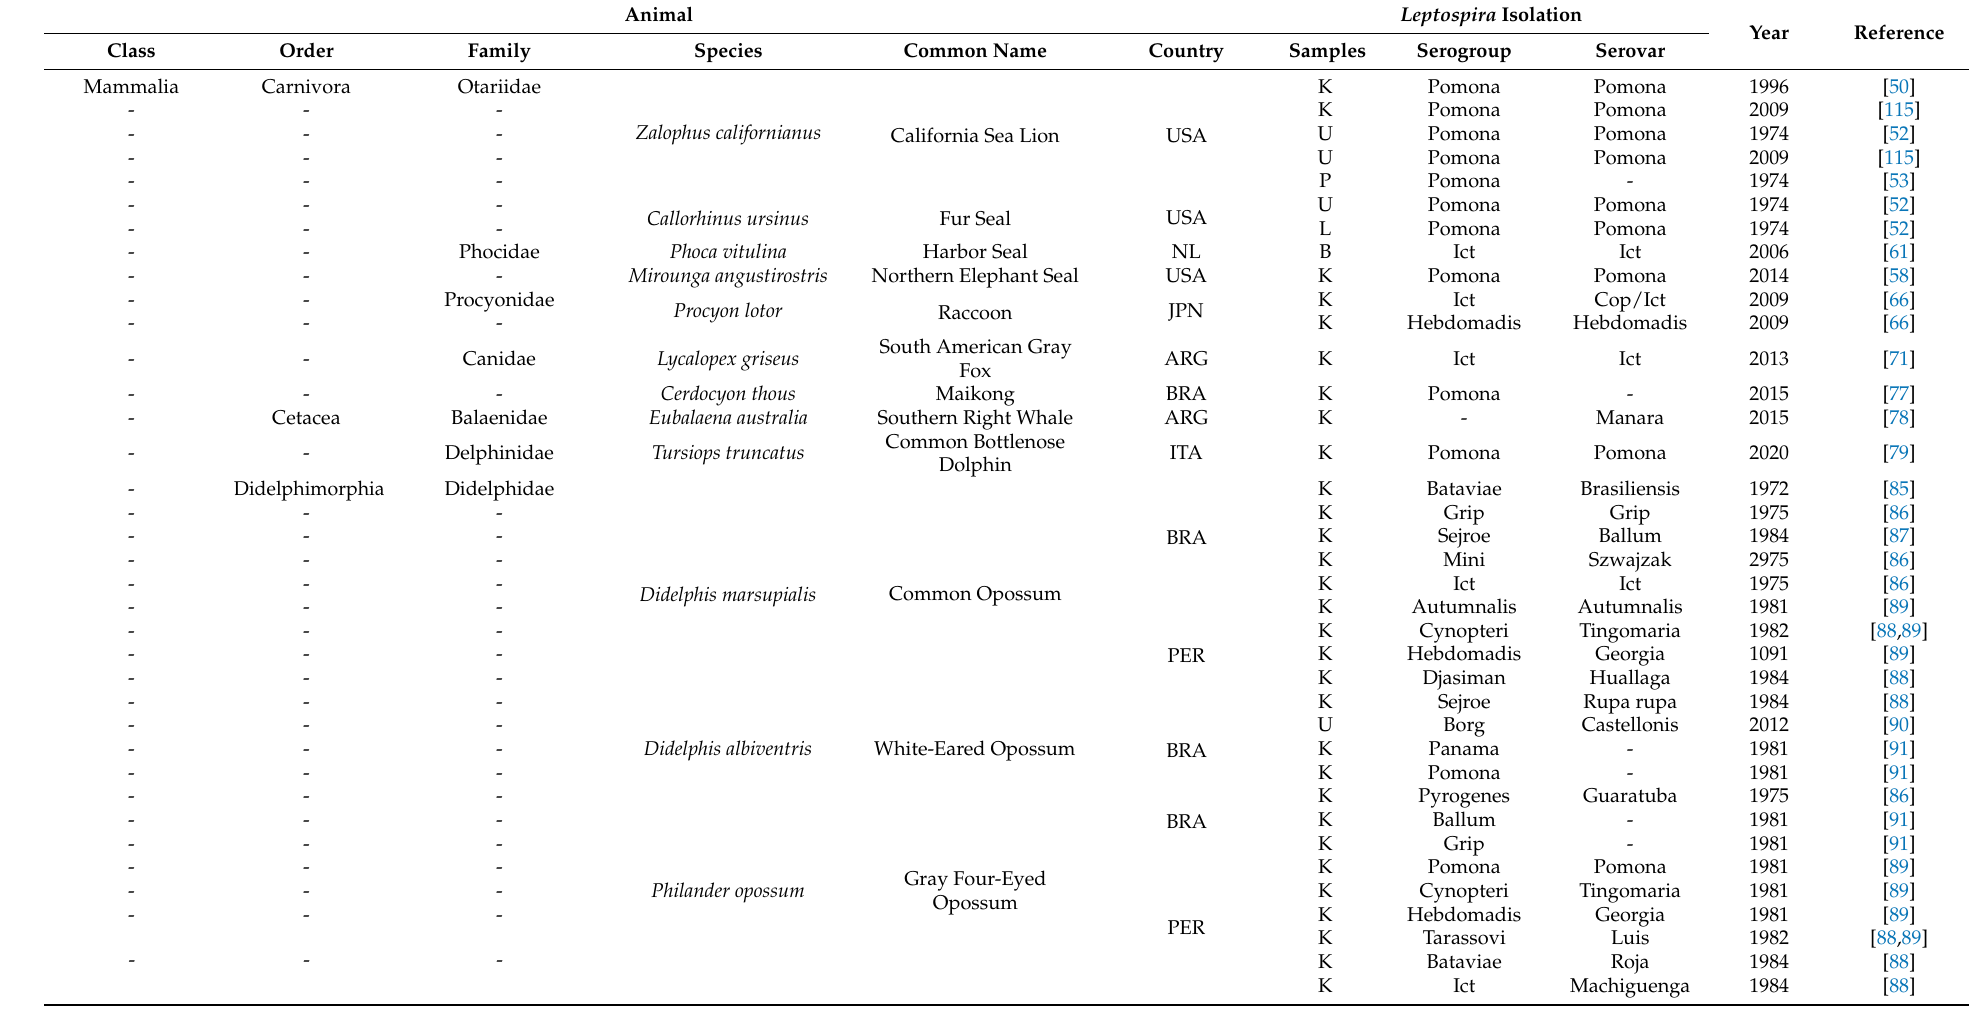
Table 1. Serogroup and Serovar of Leptospira isolated from “unconventional” host specimens, of which are reported Class, Order, Family, Species and Country of